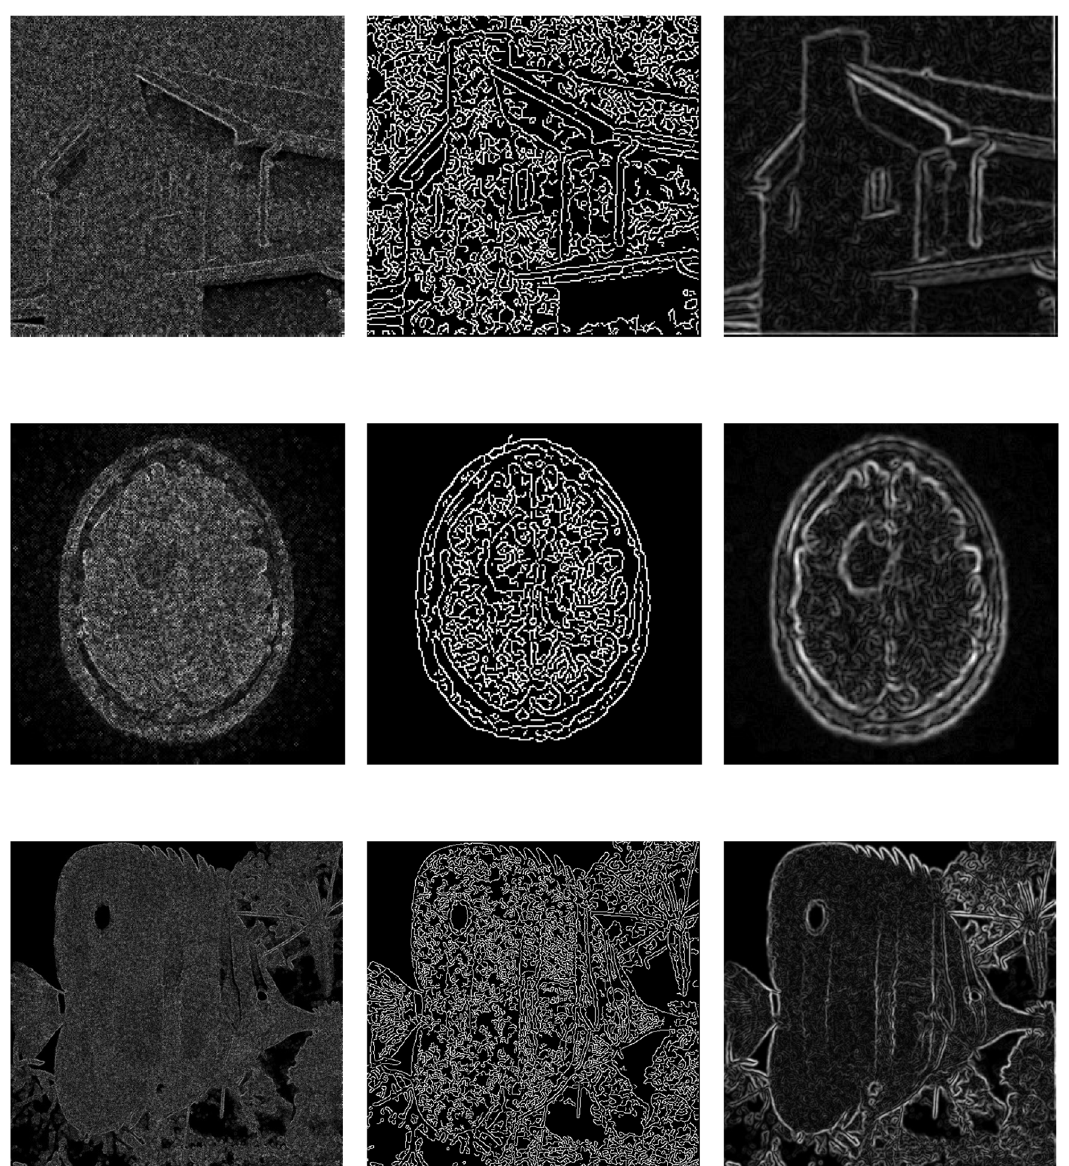
Figure 5: Detected edges: from noisy images ( left ) , by Canny method ( middle ) , and from smoothed images ( right )